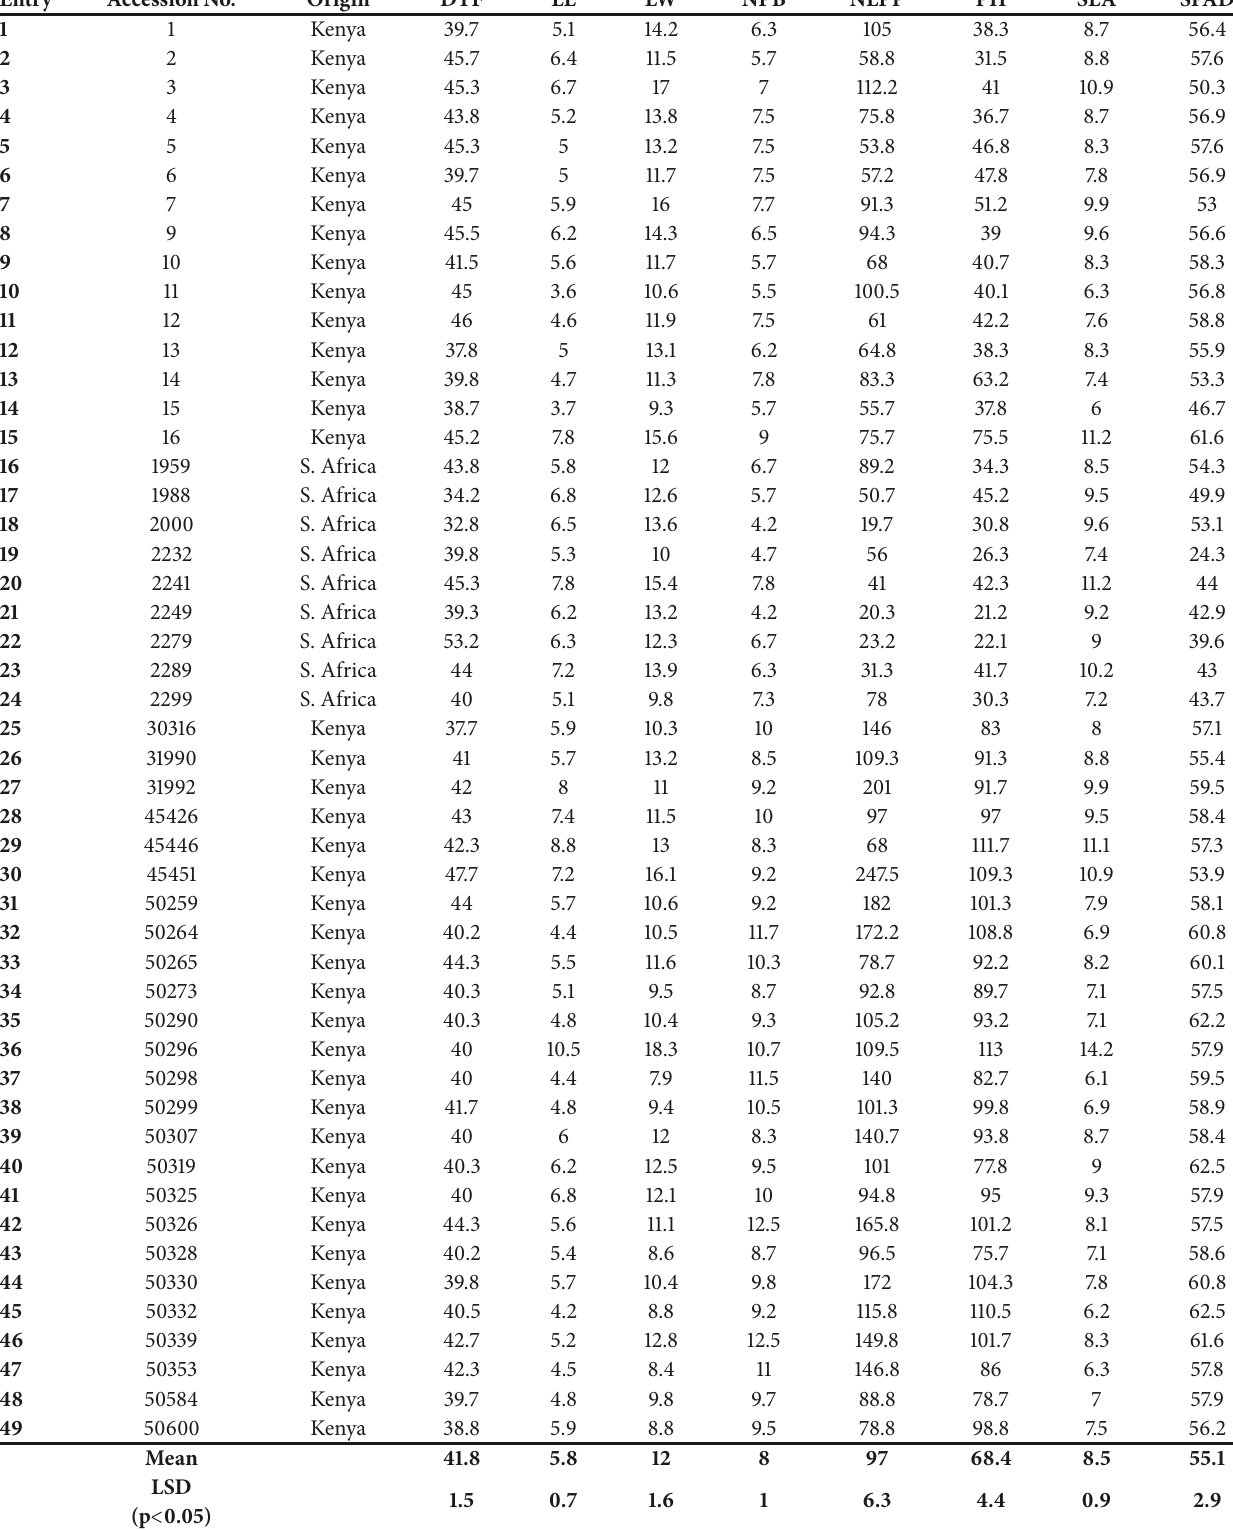
Table 5: Mean comparison of the quantitative traits of 49 spider plant accessions from Kenya and South Africa grown in the University of Nairobi Field at Kabete, for the two combined